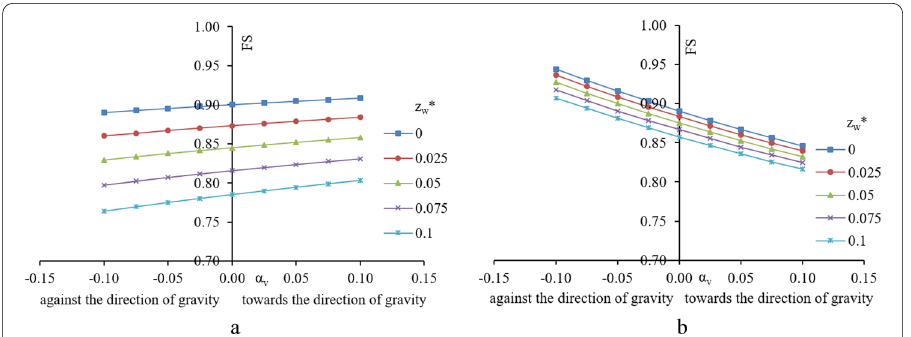
Fig. 7 FS vs α v on different values of z w *: (a) case 1 and (b) case